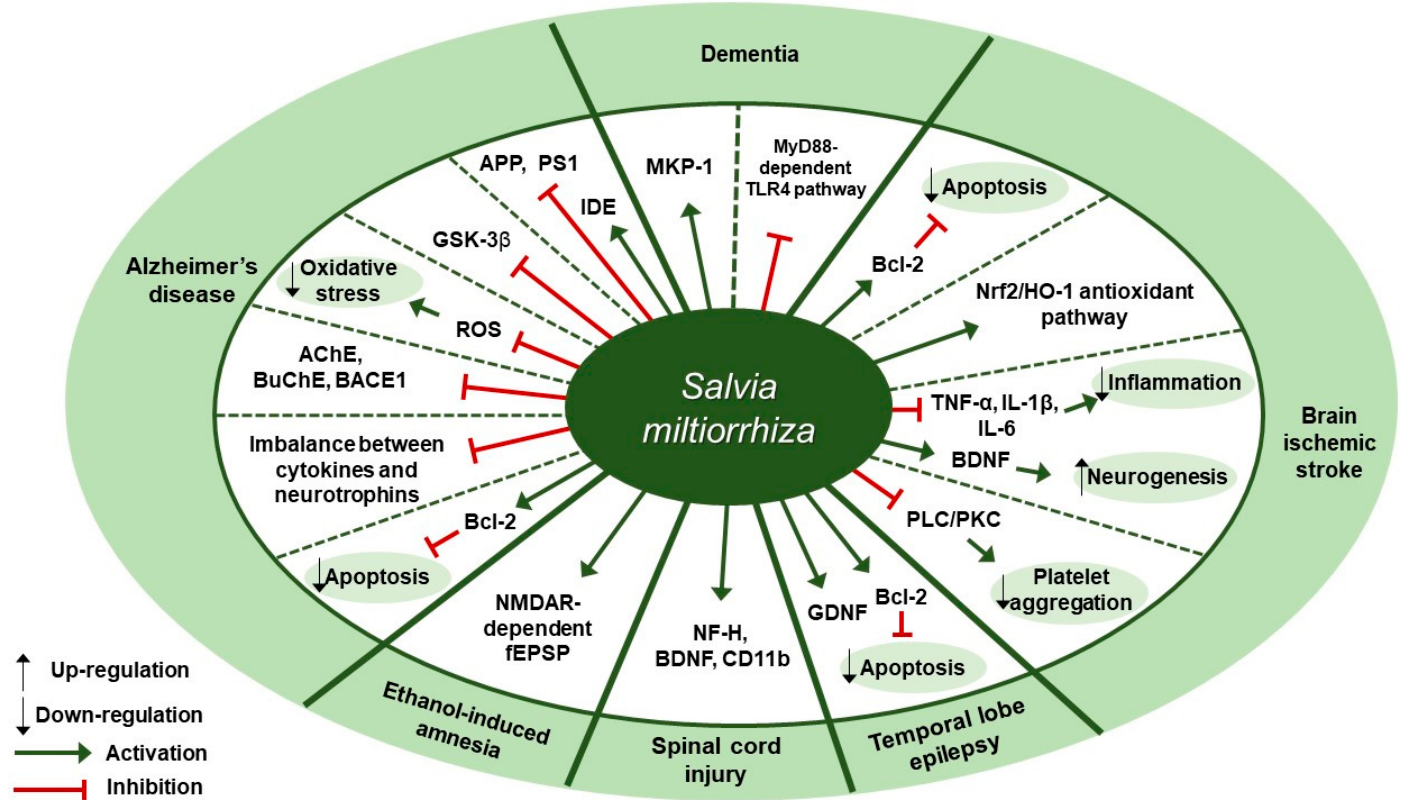
Figure 4. Therapeutic targets of S. miltiorrhiza in nervous system diseases. MKP-1, mitogen-activated protein kinase-1; MyD88, myeloid differentiation primary response 88; TLR4, toll-like receptor 4; Bcl-2, B-cell lymphoma 2; Nrf2, nuclear factor erythroid 2-related factor 2; HO-1, heme oxygenase-1; TNF- α , tumor necrosis factor- α ; IL-1 β , interleukin-1 β ; IL-6, interleukin-6; BDNF, brain-derived neurotrophic factor; PLC, phospholipase; PKC, protein kinase C; GDNF, glial cell-derived neurotrophic factor; NF-H, neurofilament 200; CD11b, cluster of differentiation molecule 11B; NMDAR, N-methyl-d-aspartate receptor; fEPSP, field excitatory postsynaptic potential; AchE, acetylcholinesterase; BuChE, butyrylcholinesterase; BACE1, β -secretase; ROS, reactive oxygen species; GSK-3 β , glycogen synthase kinase-3 β ; APP, amyloid precursor protein; PS1, presenilin-1; IDE, insulin-degrading enzyme.